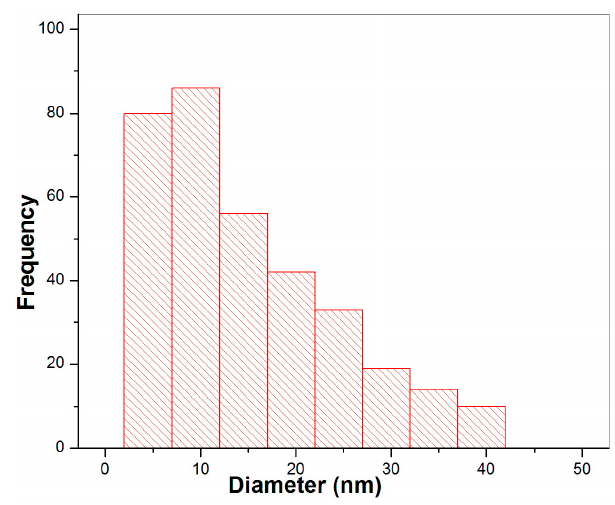
Figure 8. Histogram showing the particle sizes of AgNPs corresponding to TEM images M 9.